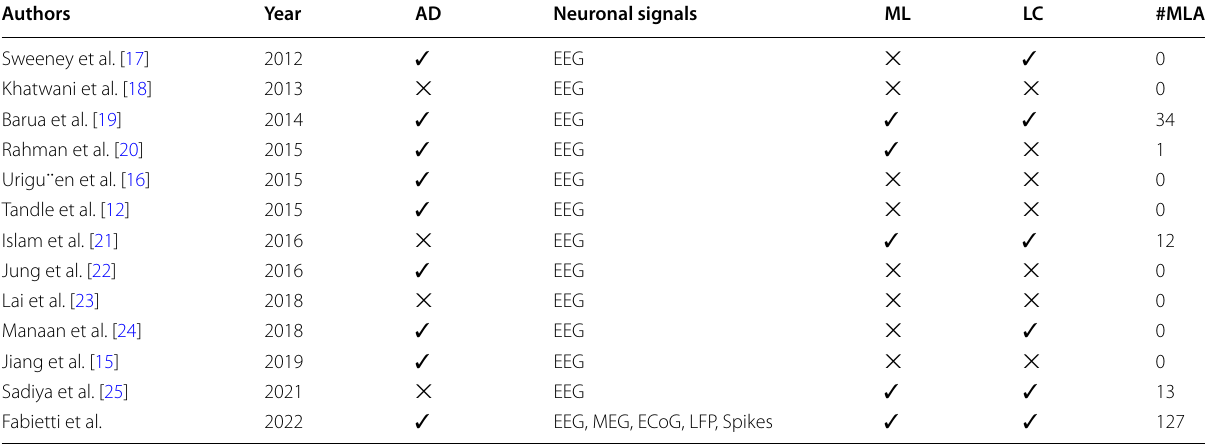
Table 1 Comparison of available reviews on methods applied to artefact removal, sorted by year of publication